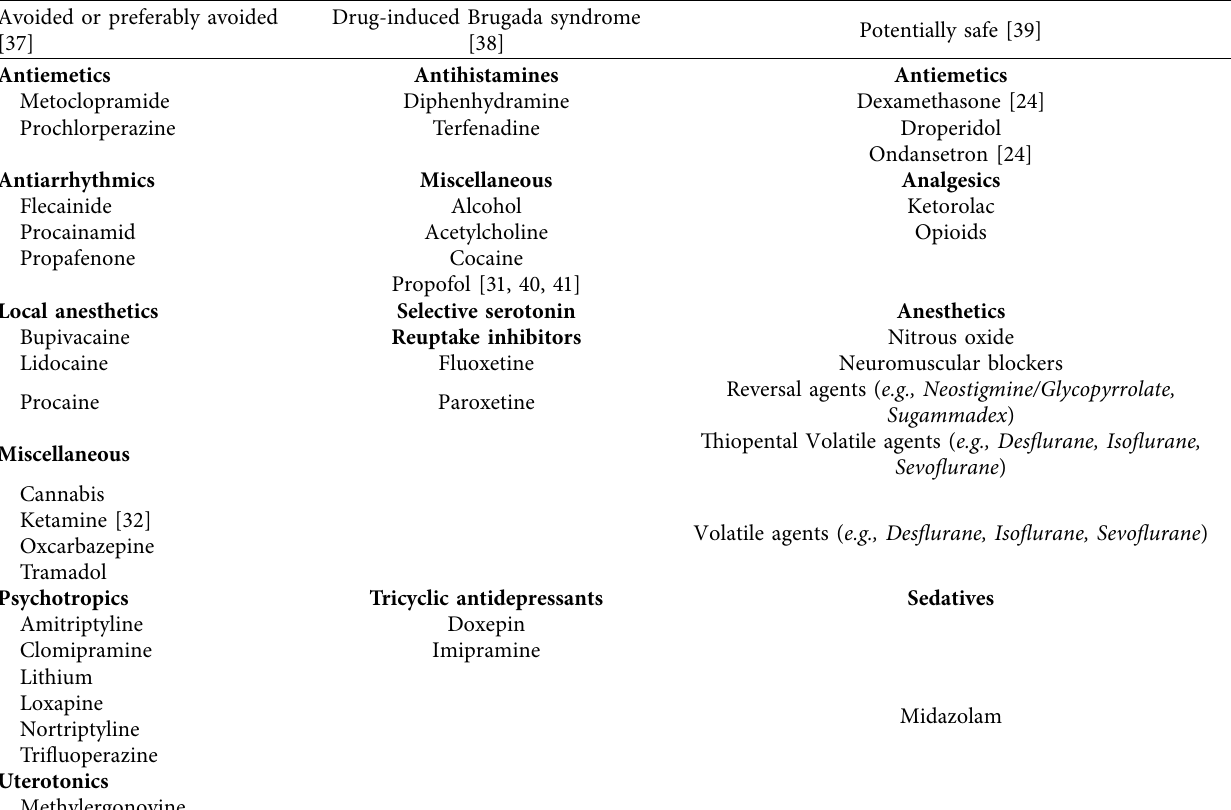
Table 2: Abbreviated list of medications and their safety profile for use in patients with Brugada